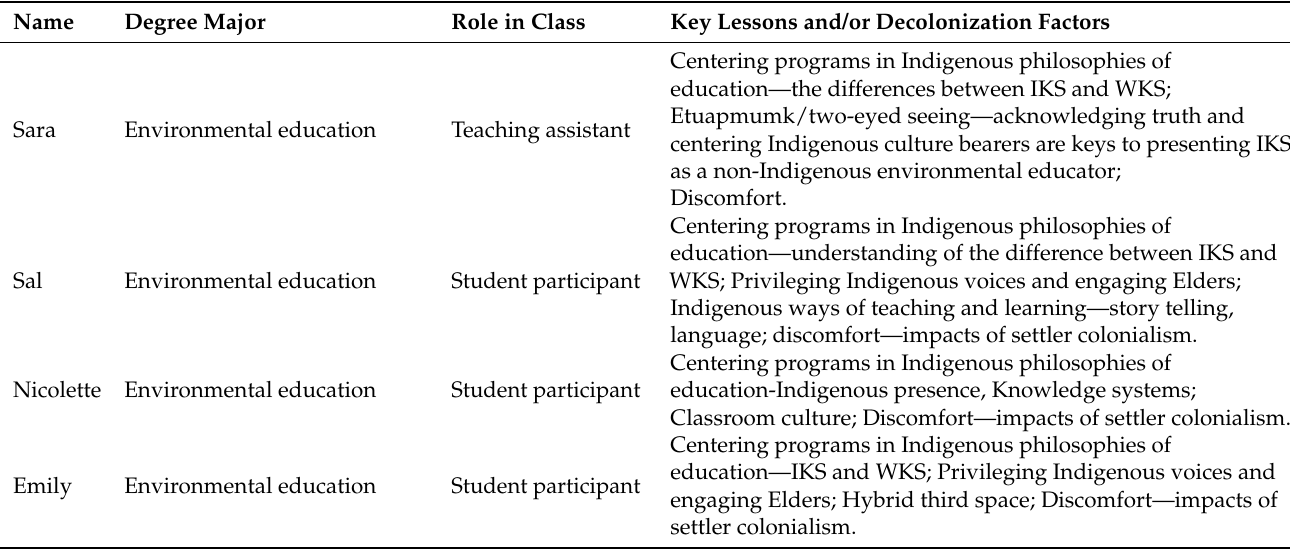
Table 2. Author Major, Role in Class and Key